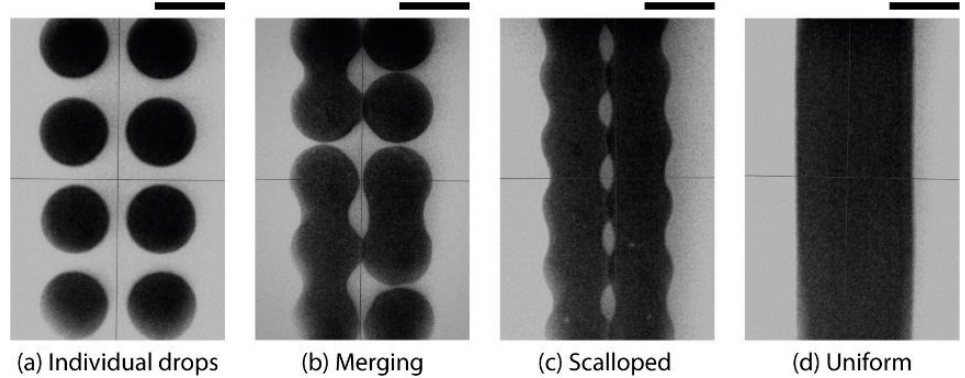
Figure 2. Snapshot of the droplet spacing optimisation. ( a ) represents individual drops; ( b ) randomly merged drops; ( c ) scalloped track; and ( d ) uniform track. The droplet spacing decreases from left to right. Scale bar is 50 µm.